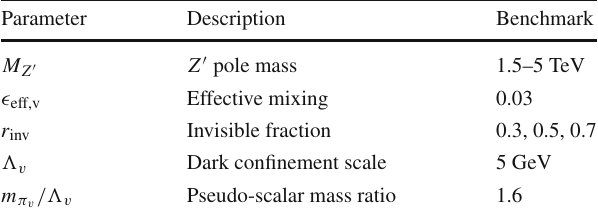
Table 1 Signal model